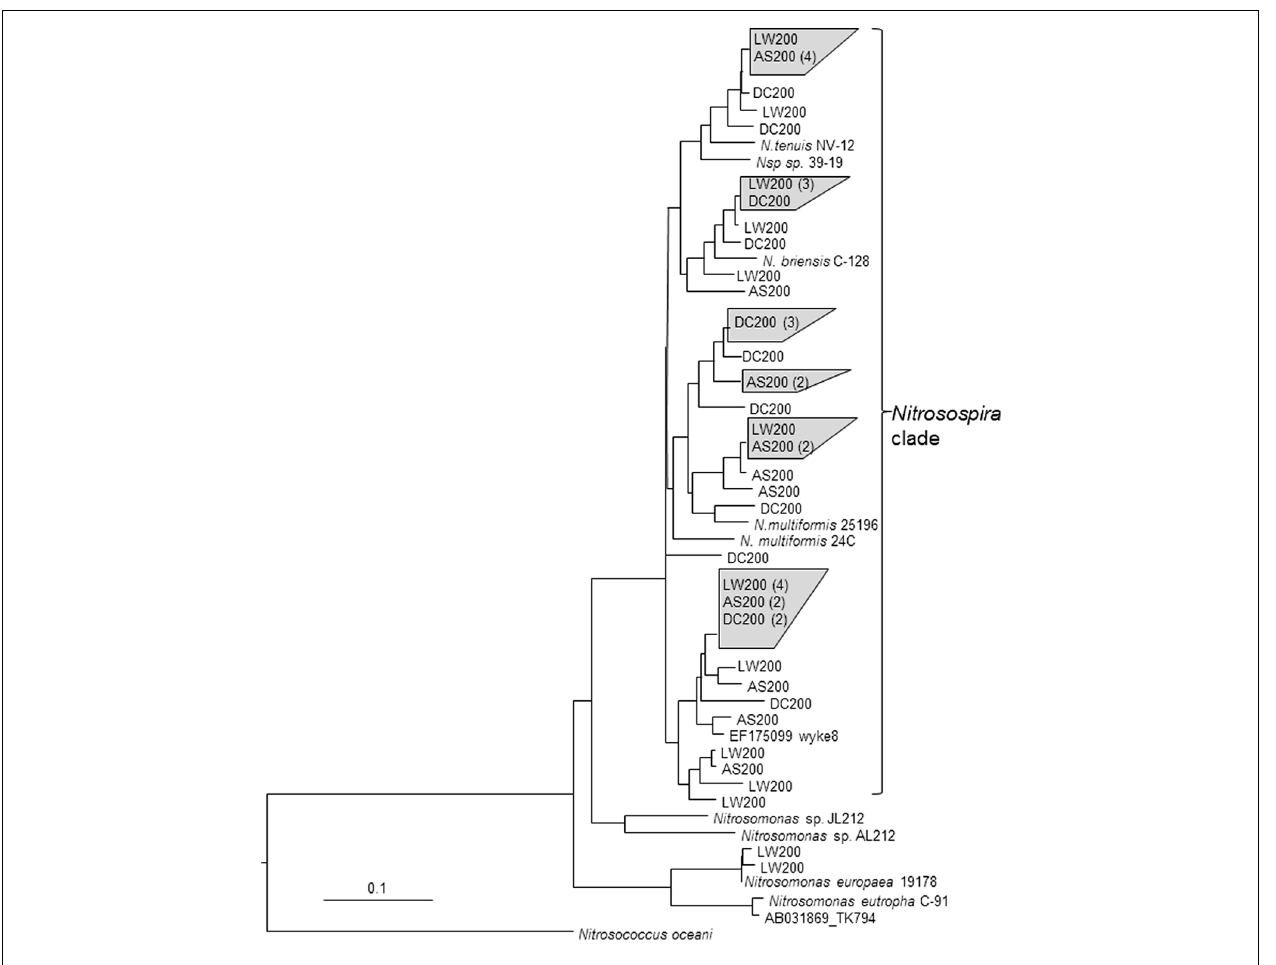
FIGURE 4 |Analysis of clone library sequences for bacterial amoA gene (534 bp). Neighbor joining tree for bacterial partial amoA sequences from soils from the various treatments (see Figure 1 ) and reference sequences from GenBank. Scale represents number